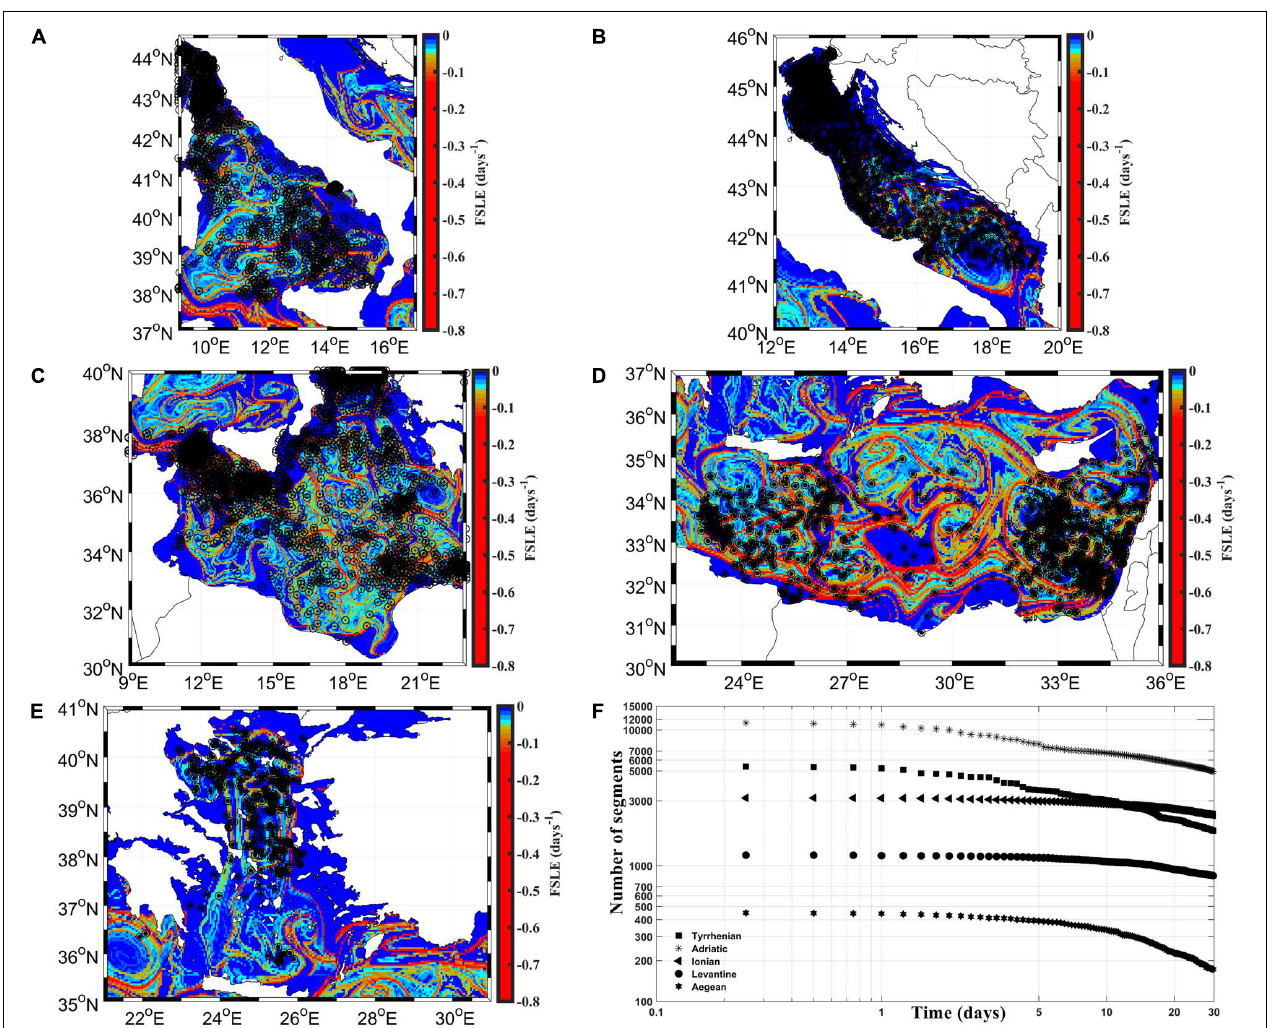
FIGURE 2 | The spatial distribution of the FSLE superposed with the initial positions of drifter segments (individual drifters, black dots inside the black circles) (A) in the Tyrrhenian, (B) the Adriatic, (C) the Ionian, (D) the Levantine, and (E) the Aegean sub-basins. The number of segments as a function of time is shown in (F)